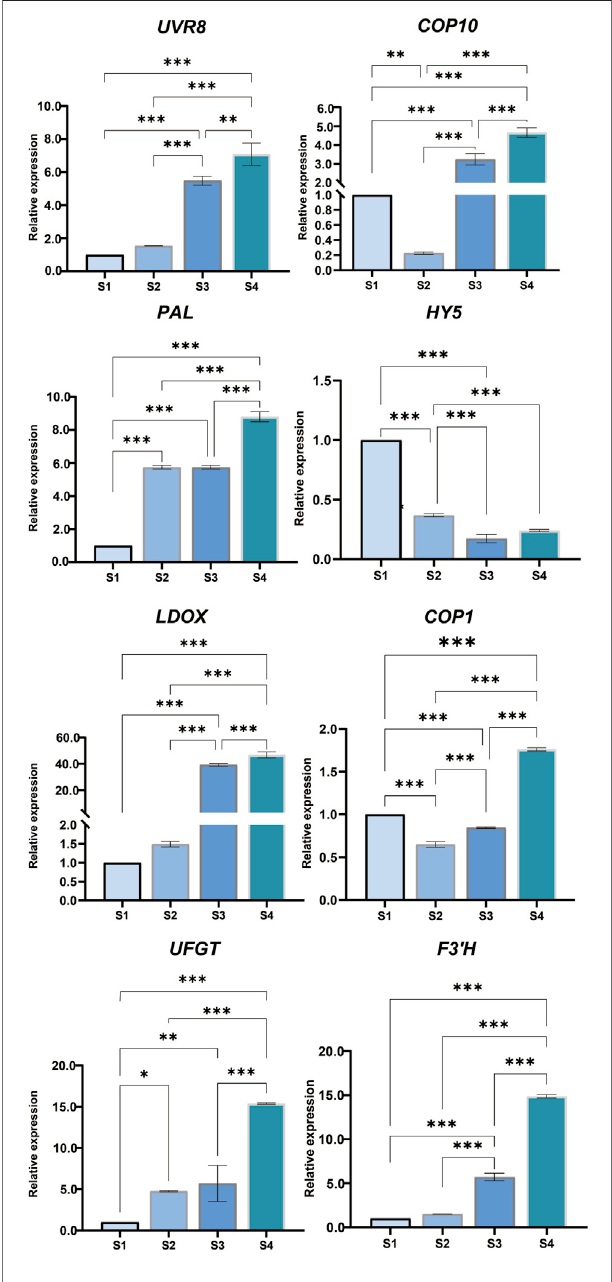
FIGURE 6 | Quantitative real-time (qRT)-PCR was used to determine anthocyanin biosynthesis-related genes UVR8 (Loc18782602) , UFGT (Loc18782003) , PAL (Loc18772065) , LDOX (Loc18777055) , HY5 (Loc18774140) , F3 ′ H (Loc18777306) , COP10 (Loc18775225) , and COP1 (Loc18778124) in peach fruit. The error bar represents the mean + standard error of three repeated measurements (SE) using one-way analysis of variance (ANOVA). p < 0.05 is represented by * and p < 0.001 is represented by ***.